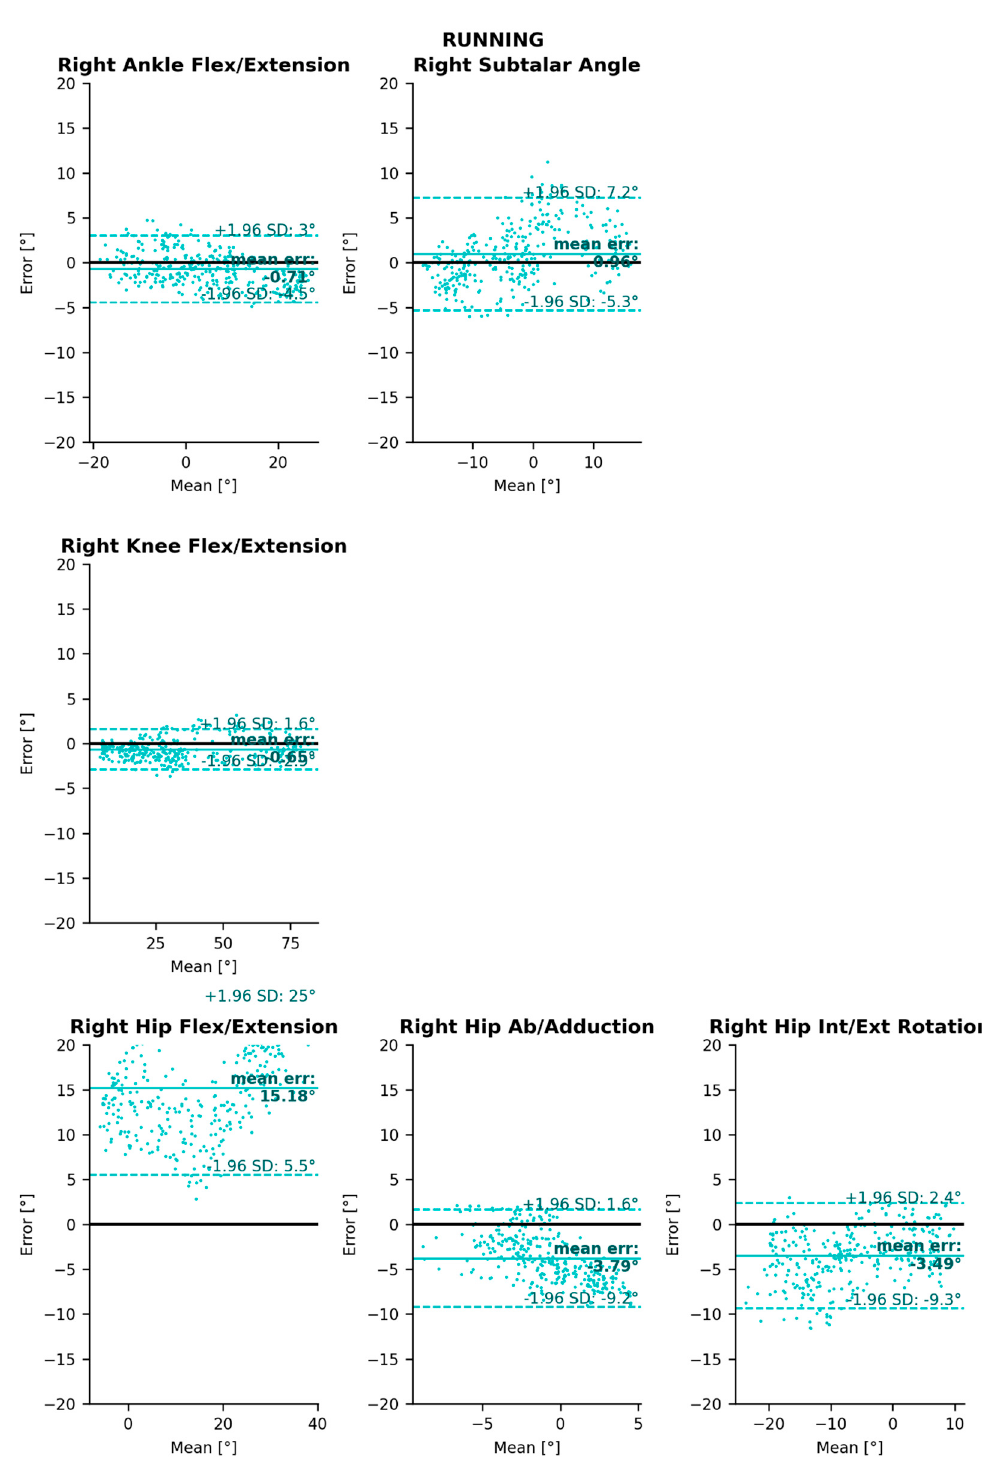
Figure A4. Bland–Altman analysis of lower-body joint angle errors for the running task. Mean bias is represented as a horizontal solid, bold line, and 95% limits of agreement are represented as dotted lines.